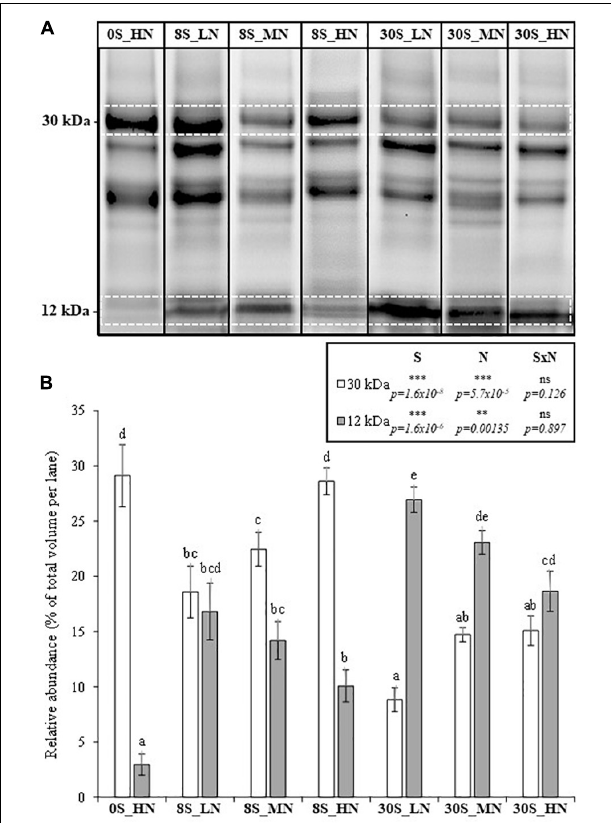
FIGURE 4 | SDS–PAGE of proteomic profiles from mature seeds (A) and the relative abundance (% of total volume per lane) of a 30-kDa protein (cruciferin, S-poor protein) and a 12-kDa protein (napin, S-rich protein) in mature seeds (B) of plants grown under 0S_HN, 8S_LN, 8S_MN, 8S_HN, 30S_LN, 30S_MN, and 30S_HN conditions. A : for a given treatment, the SDS–PAGE was performed with the averaged sample of proteins prepared after mixing the protein extracts from the four or five biological replications. The images of each averaged sample corresponding to each treatment were grouped together in Figure 4A . In B : for a given treatment, each biological replication was performed in SDS–PAGE (see Supplementary Data in Supplementary Figure S1 ) in order to determine the mean value for the relative abundance of proteins at 12 and 30 kDa proteins. Vertical bars indicate ± SE of the mean ( n = 5 for 0S_HN, 8S_MN, and 30S_MN, n = 4 for 8S_HN, 8S_LN, 30S_HN, and 30S_LN). Different letters indicate that mean values are significantly different ( p < 0.05) between treatments. S, N, and S × N effects were estimated by omitting 0S_HN condition. ∗ p < 0.05; ∗∗ p < 0.01; ∗∗∗ p < 0.001; ns, not significant.